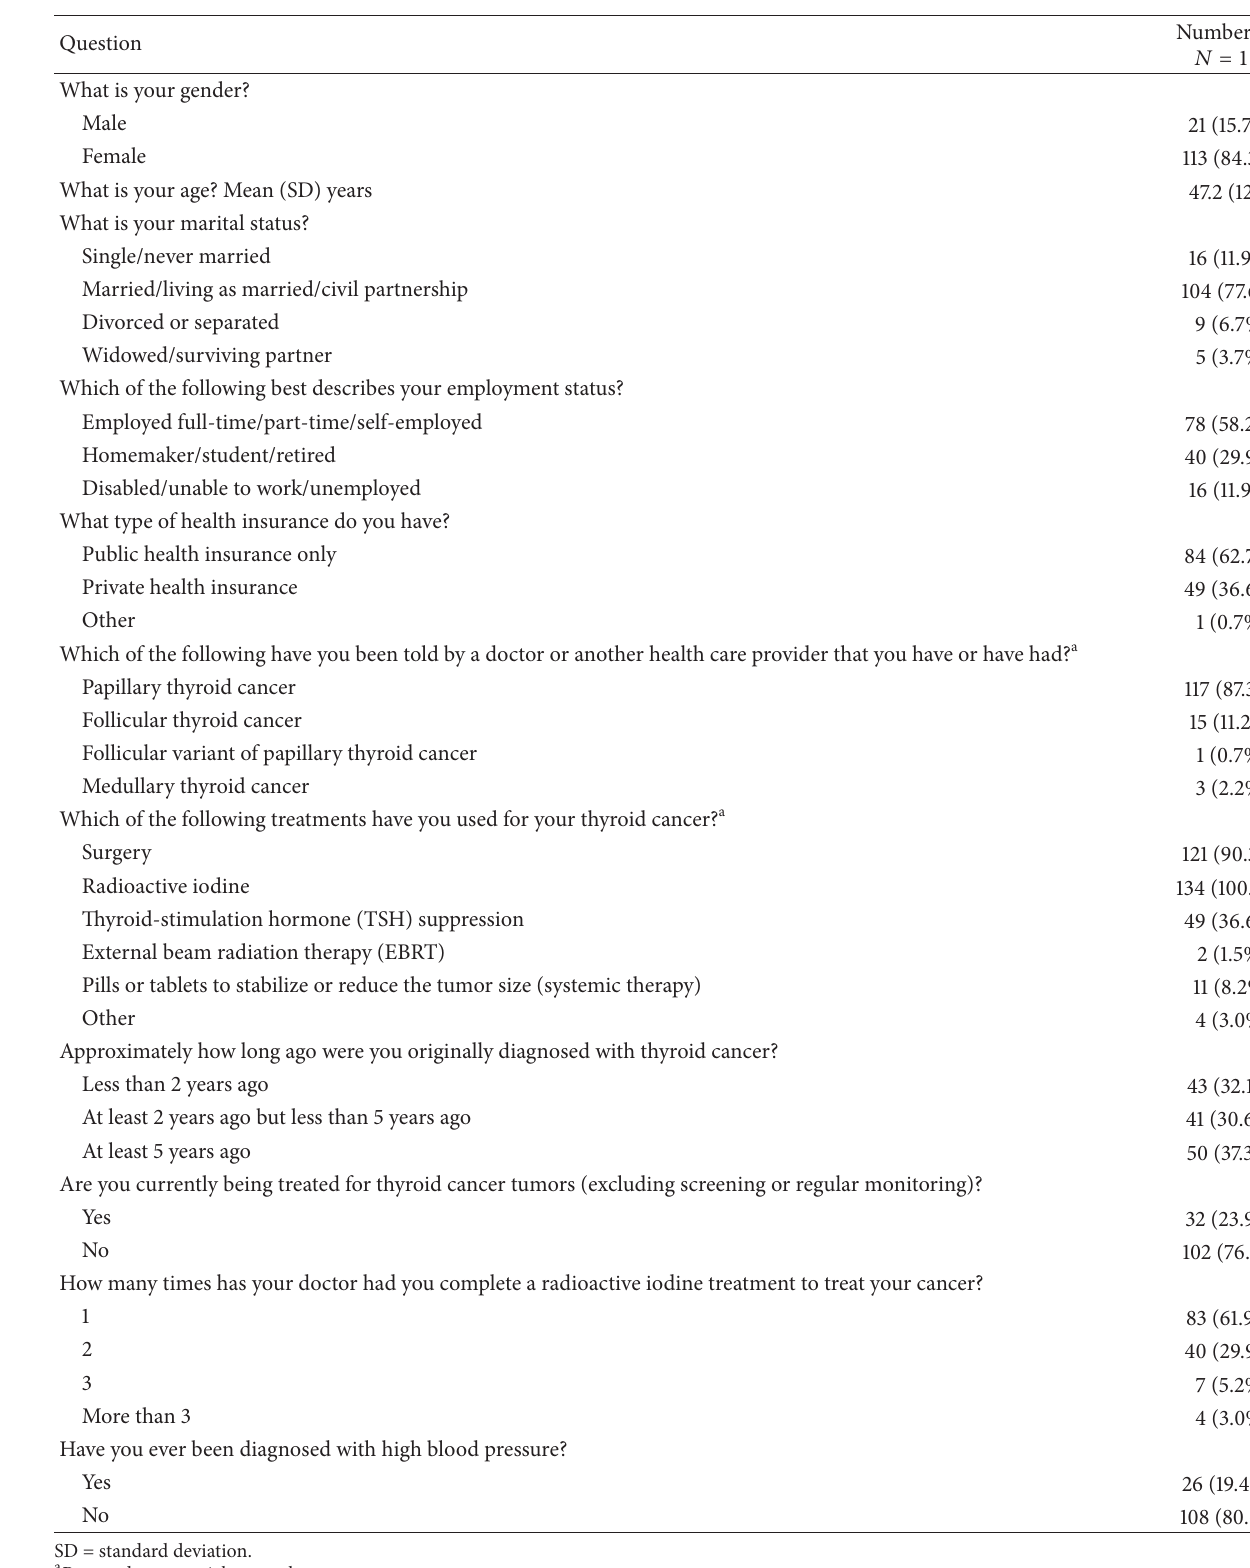
Table 3: Summary of patient